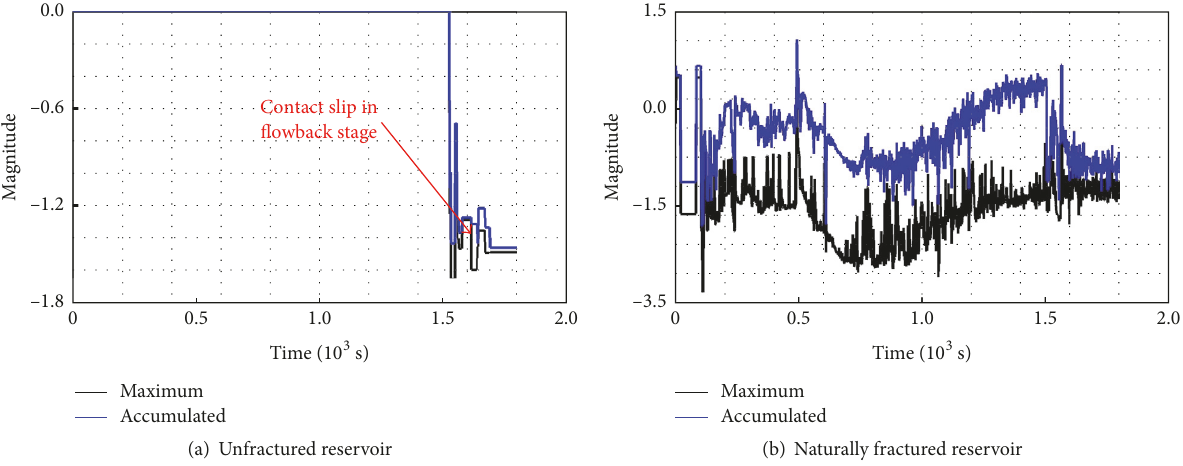
Figure 9: Evolution of maximum magnitude and accumulated magnitude of contact slip events.